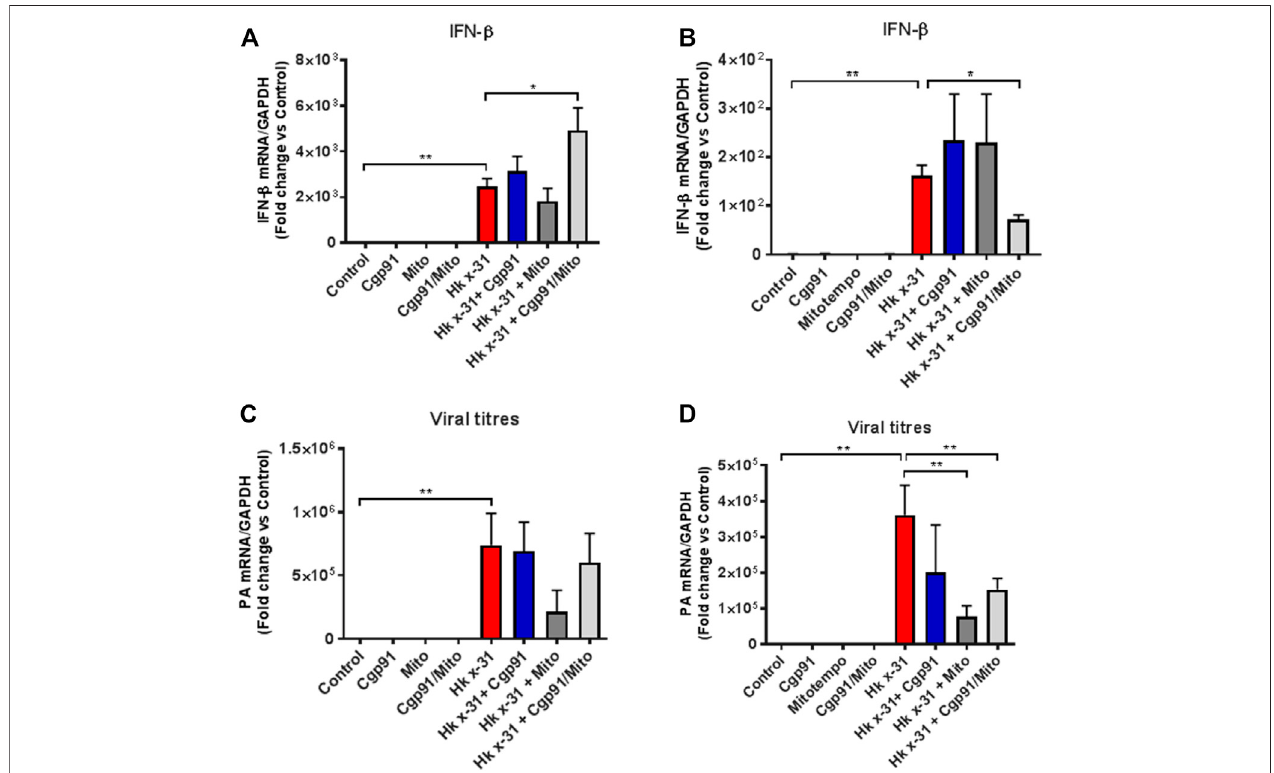
FIGURE4| LungIFN- β andviralmRNAexpressionatanearlyandlatestageofin fl uenzaAvirusinfection.MicewereinfectedwithHxx-31at(10 4 PFUs)orPBS via intranasal administration. Animals were treated once daily 1 day following infection via intranasal administration with a combination of Cgp91ds-TAT (0.2 mg/kg) and mitoTEMPO(100 µg)orROSinhibitorsaloneovera2 daysperiodforIFN- β analysisat (A) day3piand (B) day6pi.andmRNAanalysisofthegeneencodingpolymerase of in fl uenza virus strain by QPCR in (C) at day 3 pi and (D) day 6 pi. IFN- β and viral PA were quanti fi ed in lung tissue. Responses are relative to GAPDH and expressedasafold-changeabovenaïvecontrols.Dataareexpressedasmean±SEM(Control, n =6;Cgp91, n =4;mitoTEMPO n =4;Cgp91/Mito, n =8;Hkx31, n